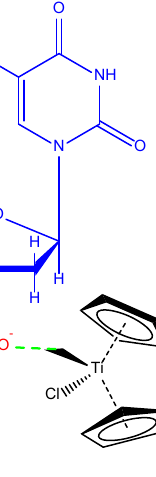
phosphate, black: